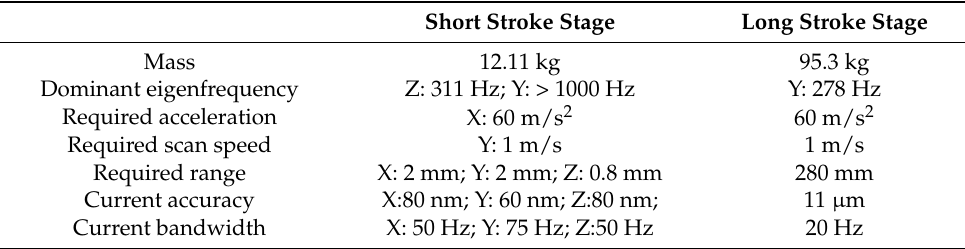
Table 1. Structural and performance parameters of the Dual-Stage Actuator (DSA) system.